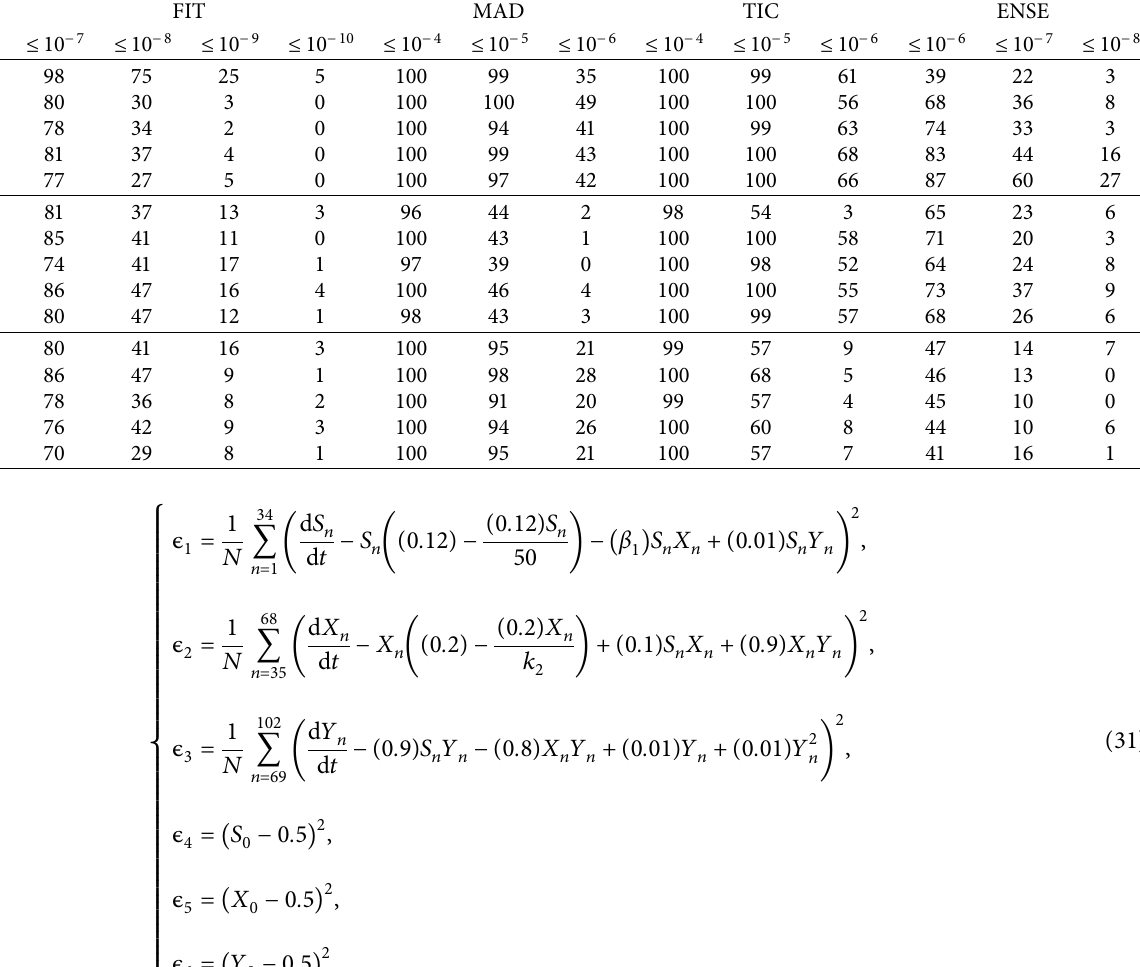
. 1 on the prey-predator 1